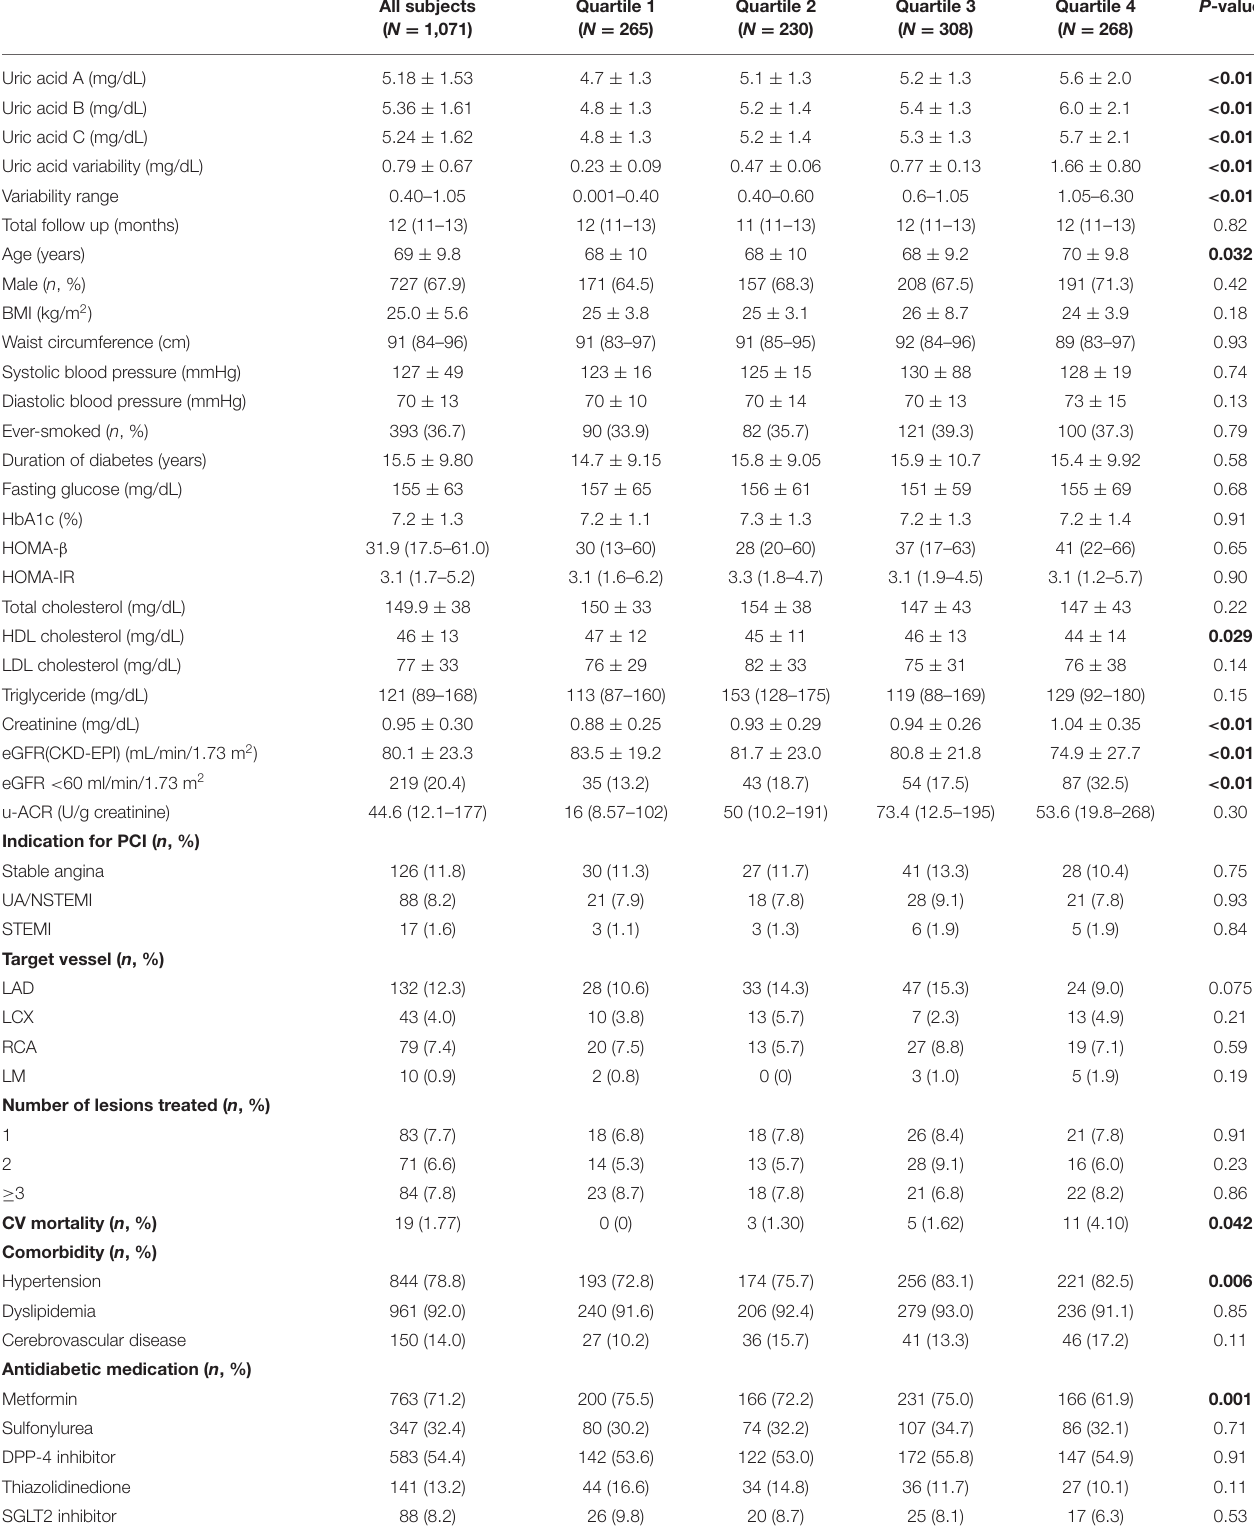
TABLE 1 | Baseline characteristics according to quartiles of uric acid